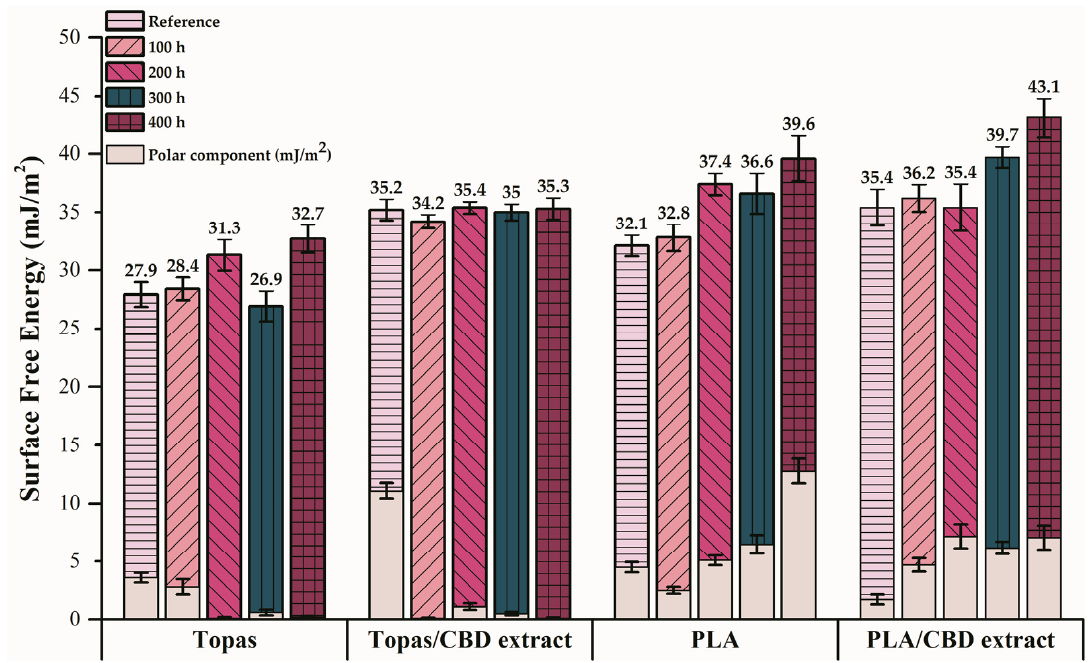
Figure 1. Changes caused by weather-aging in surface free energy (SFE) of pure ethylene–norbornene copolymer (Topas), polylactide (PLA), and these polymers with cannabidiol (CBD) content.